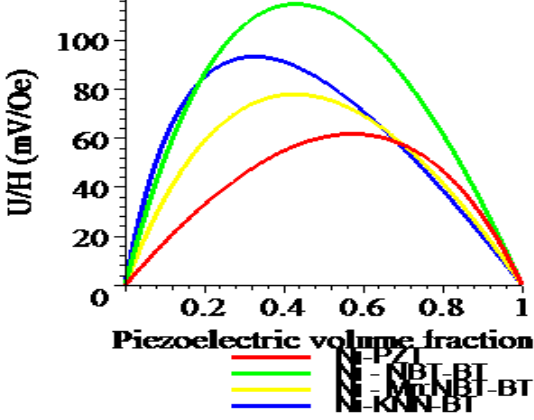
Figure 10. Piezoelectric volume fraction dependence of longitudinal ME voltage coefficient for a bilayer of Ni and piezoelectrics.